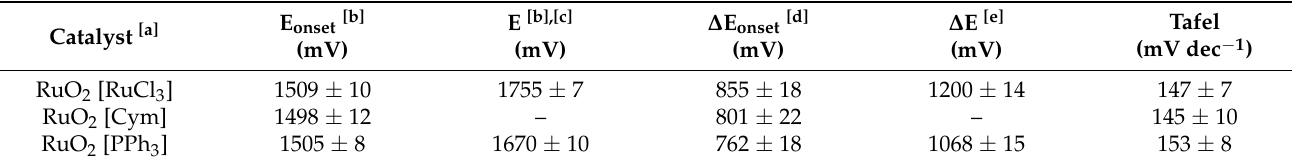
Figure 8. ( A ) LSV in the oxidation branch, showing the OER onset potential of each material in 0.1 M KOH. ( B – D ) CV, including the ORR and OER ranges for RuO 2 [RuCl 3 ], RuO 2 [Cym], and RuO 2 [PPh 3 ] at 900 ◦ C in 0.1 M KOH. Numbers indicate the ∆ E onset (E OER − E ORR ) values included in Table 2. Dashed lines are included as eye guides. ( E ) CV obtained for RuO 2 [PPh 3 ] at 900 ◦ C in 0.1 M KOH at 1600 rpm and scan rate of 100 mV s − 1 , demonstrating the stability of this material for ORR and OER processes. Table 2. Summary of results for the OERs obtained from the data in Figure 8.